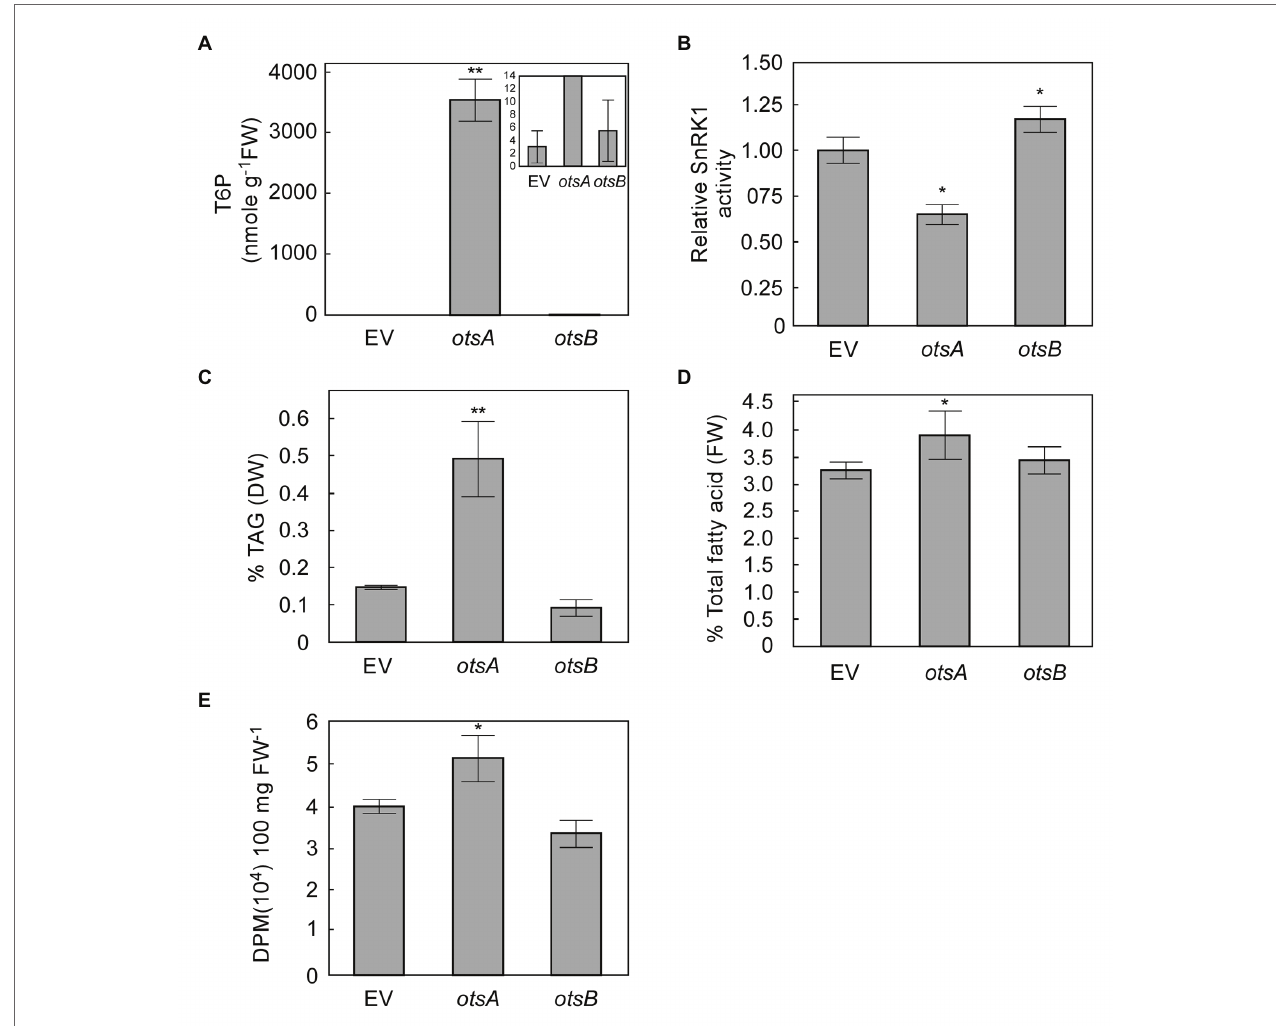
FIGURE 2 | Transient expression of TPS (otsA) increases biosynthesis of both triacylglycerol (TAG) and total fatty acid in Nicotiana benthamiana leaves. (A) T6P contents in 5-week-old N. benthamiana leaves transformed with empty vector (EV) or expressing otsA or otsB for 3 days. Values represent mean ± SD, n = 5 biological replicates (Student’s t -test, * p < 0.05; ** p < 0.01). (B) SnRK1 activity in crude extracts of infiltrated N. benthamiana leaves described in (A) . TAG (C) and total fatty (D) were quantified in the samples described in (A) . (E) [1- 14 C] acetate incorporation into fatty acyl products by strips of N. benthamiana leaves transiently expressing genes as indicated. Values represent mean incorporation ± SD ( n = 5) after 30 min of labeling. Asterisks denote statistically significant differences from the EV control material (Student’s t -test, * p < 0.05; ** p <